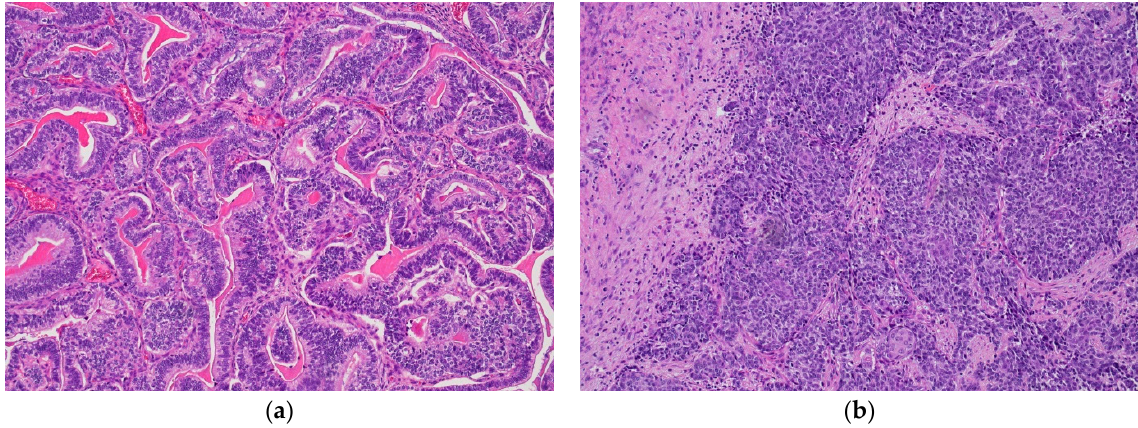
Figure 5. ( a ) Endometrioid ovarian carcinoma, low-grade: back-to-back glands without intervening stroma (hematoxylin- eosin; x100); ( b ) endometrioid ovarian carcinoma, high-grade, solid growth pattern (hematoxylin-eosin; x100).